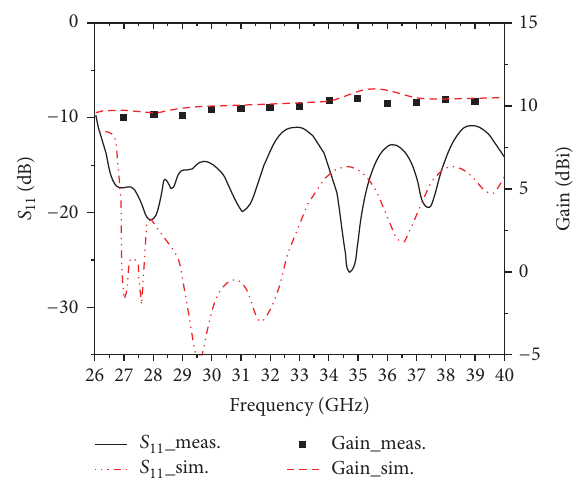
Figure 9: Simulated and measured reflection coefficients and gains of the receiving Vivaldi antenna.